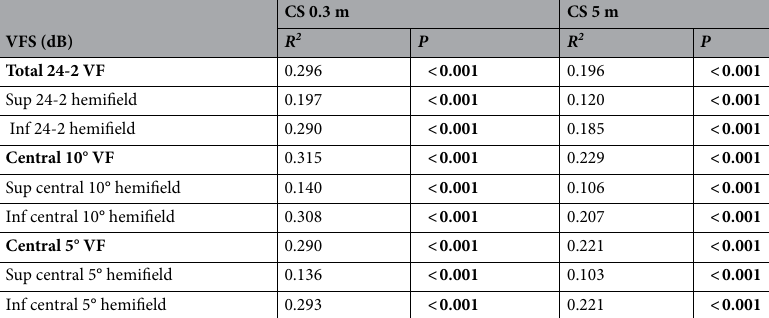
Table 4. Correlations between the visual field sensitivities in various sectors and the contrast sensitivity in POAG eyes after adjusting age. Bonferroni correction was used for multiple comparisons. P value < 0.0083 (0.05/6) was considered significant. Statistically significant values are shown in bold. POAG = primary open-angle glaucoma; CS = contrast sensitivity; VFS = visual field sensitivity; VF = visual field; Sup = superior; Inf =